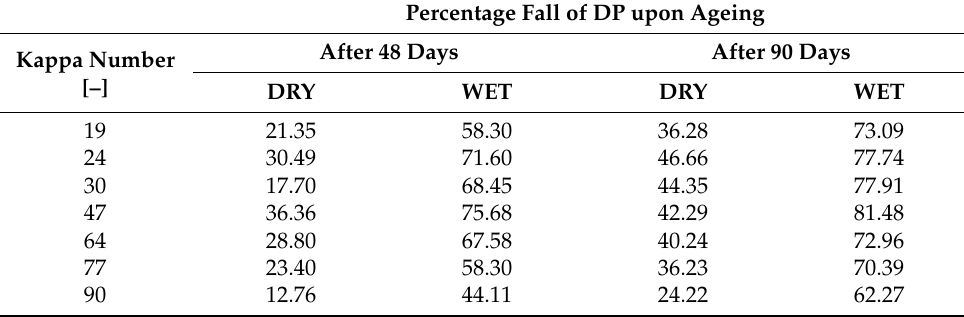
Table 1. Decrease in DP values after 48 and 90 days of ageing.